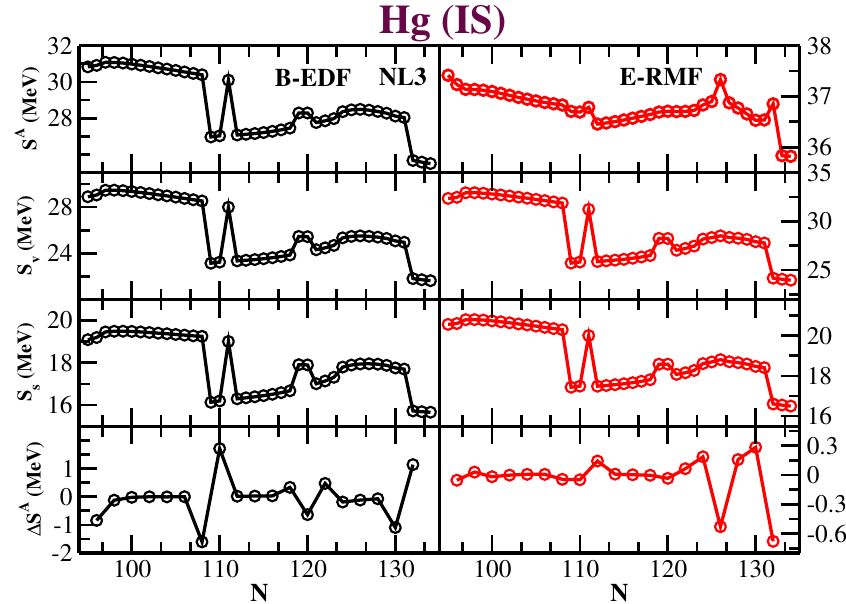
Figure 7. (Color online) Same as Figure 6, but for isomeric states of